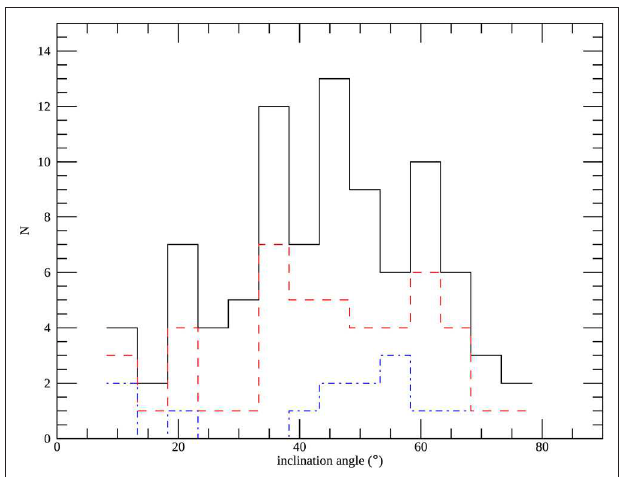
FIGURE 15 | Distribution of inclination angles for stars with v sin i from APOGEE for stars with A max,pred / Noise > 0.94. The red dash line represents the least active stars ( < S ph >< S ph, ⊙ ,max ) while the blue dot-dash line represents the least active stars with a super-solar